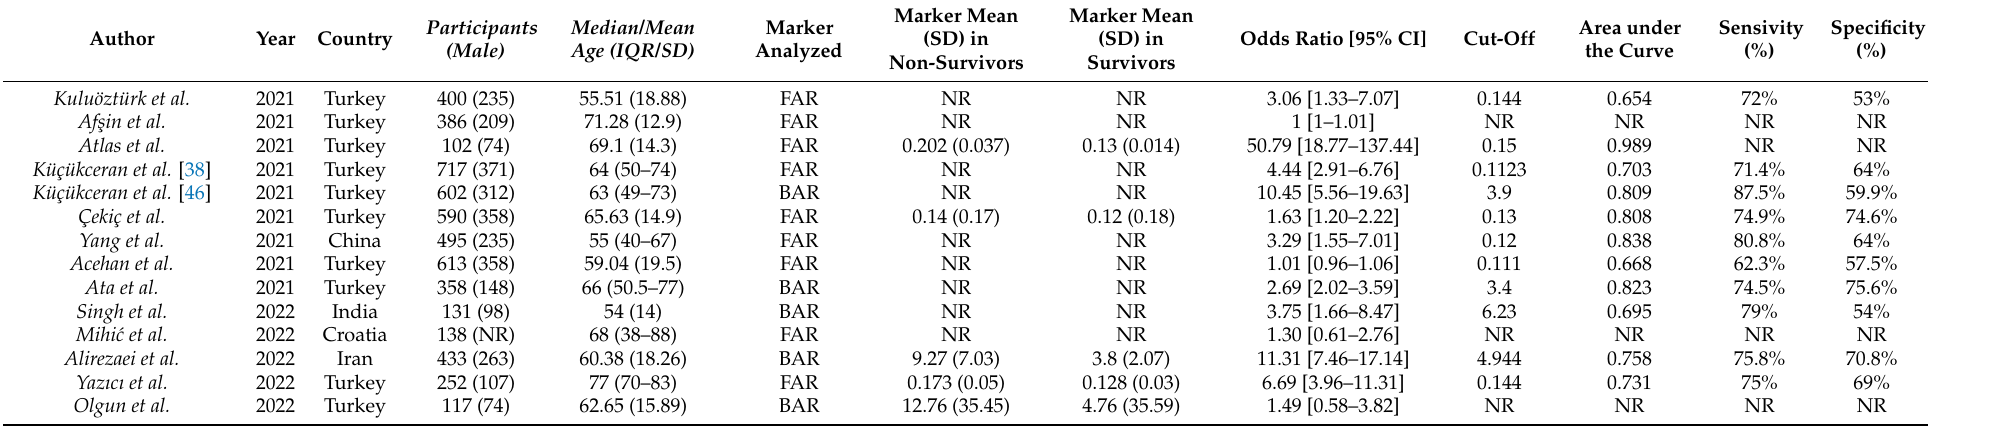
Table 2. Characteristics of the included studies that evaluated the